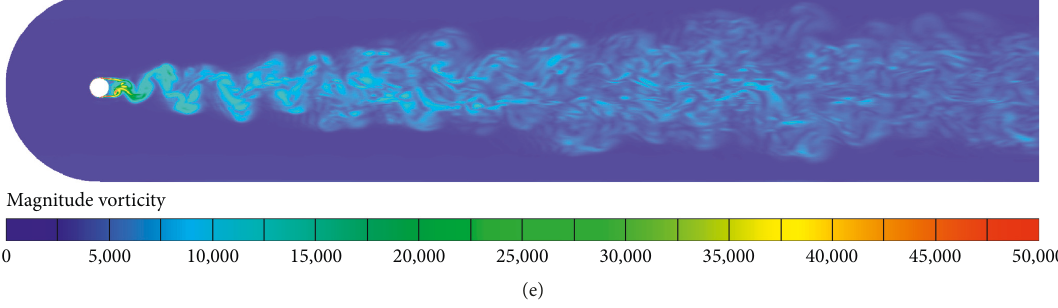
Figure 3: Cylindrical vorticity amplitude of the five models: (a) LES, (b) SAS, (c) IDDES sst-k ω , (d) DDES sst-k ω , and (e) DDES R-k ε